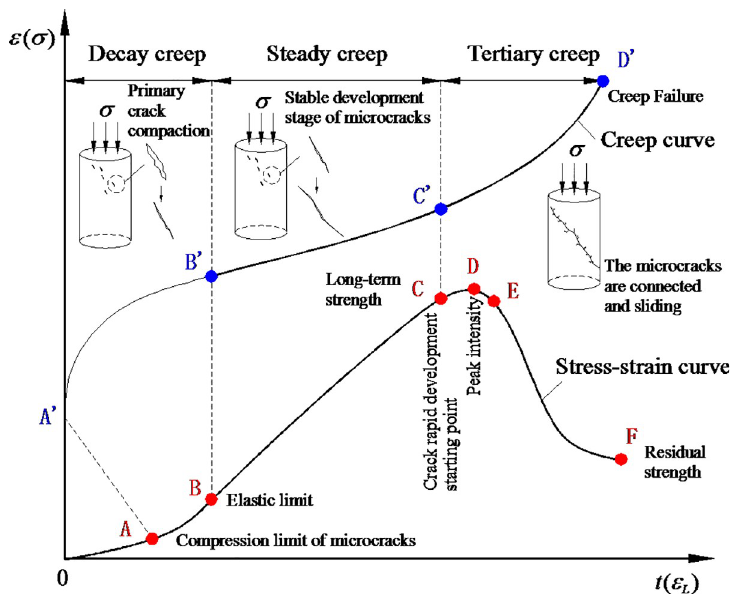
Fig 1. Comparison of total stress-strain curve and creep